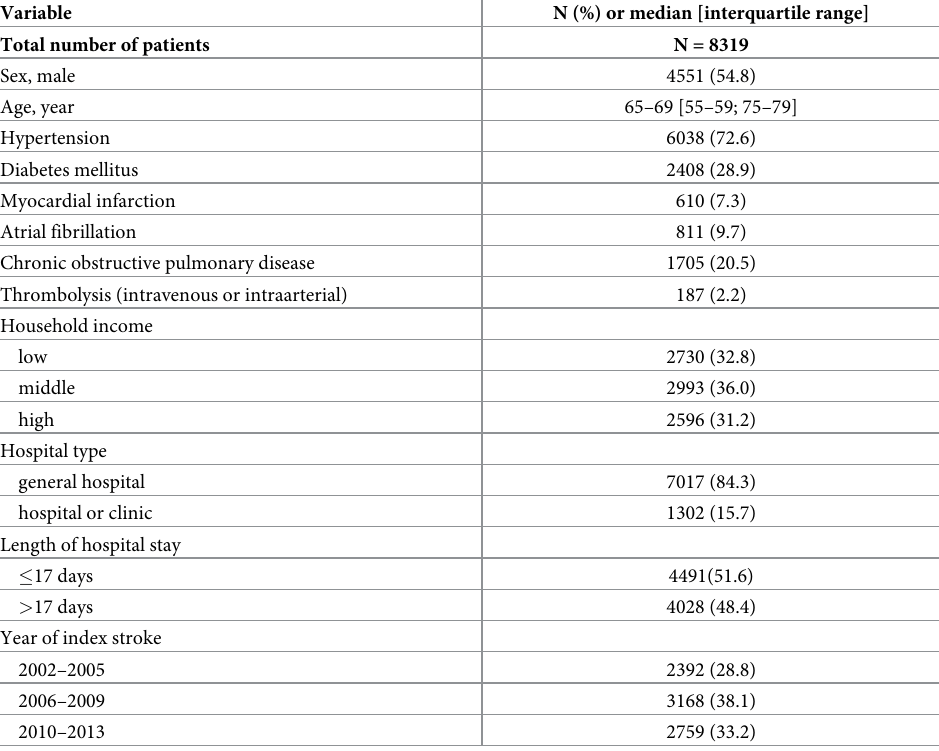
Table 1. Baseline characteristics of included